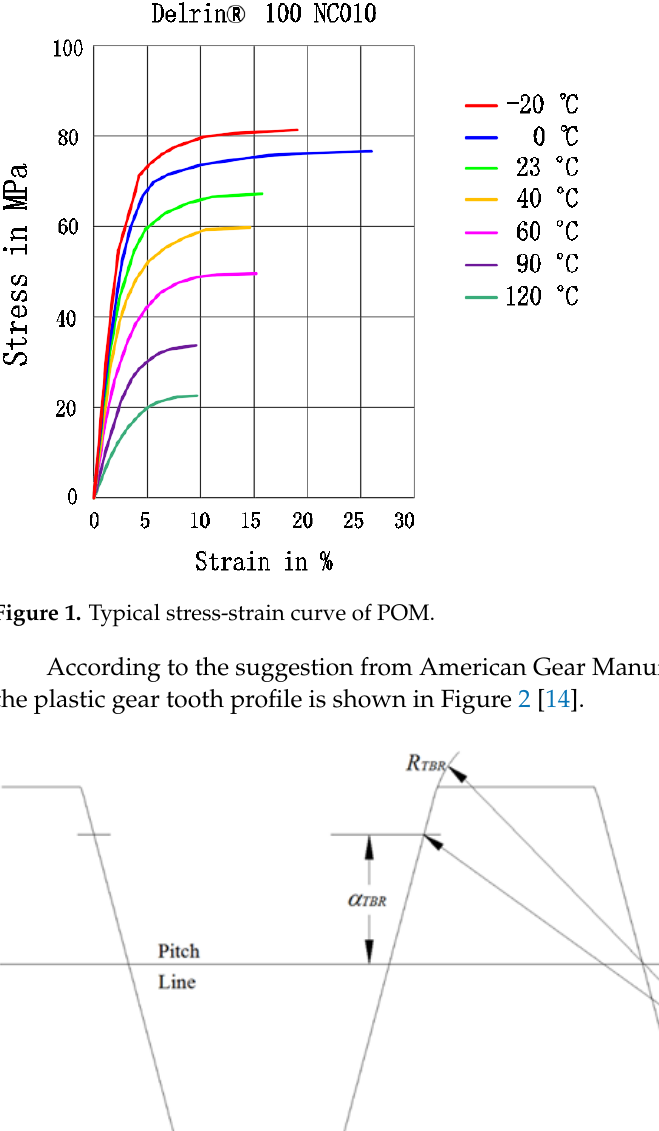
Figure 1. Typical stress-strain curve of POM.